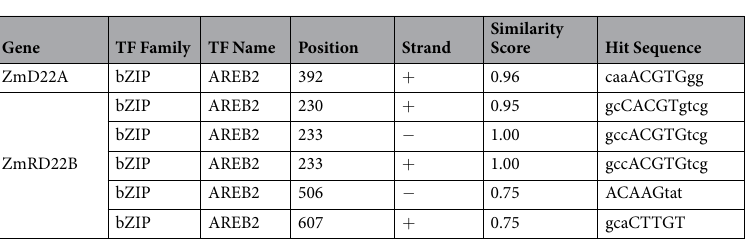
Table 2. Identification of transcription factor binding sites involved in responses to abscisic acid.